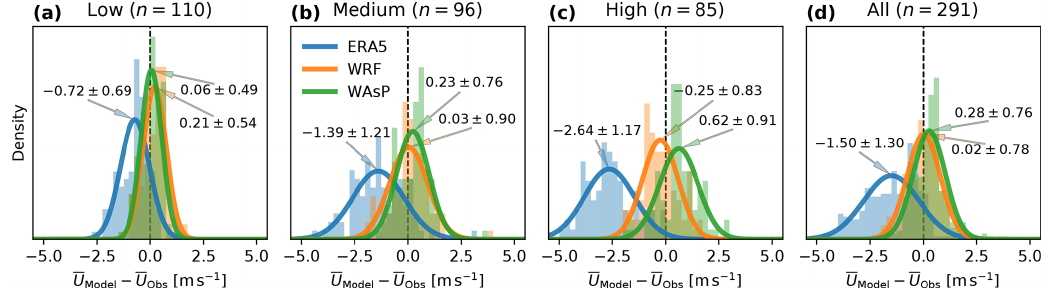
Figure 9. Distributions of wind speed biases ( U Model − U Obs ) for ERA5, WRF, and WAsP split by ruggedness index (RIX) category: low (a) , medium (b) , high (c) , and all of the samples combined (d) . Fitted normal distributions (lines) are annotated by the mean and standard deviation of the samples ( µ ± σ ). The number of masts ( n ) in each category is indicated above the subplots.